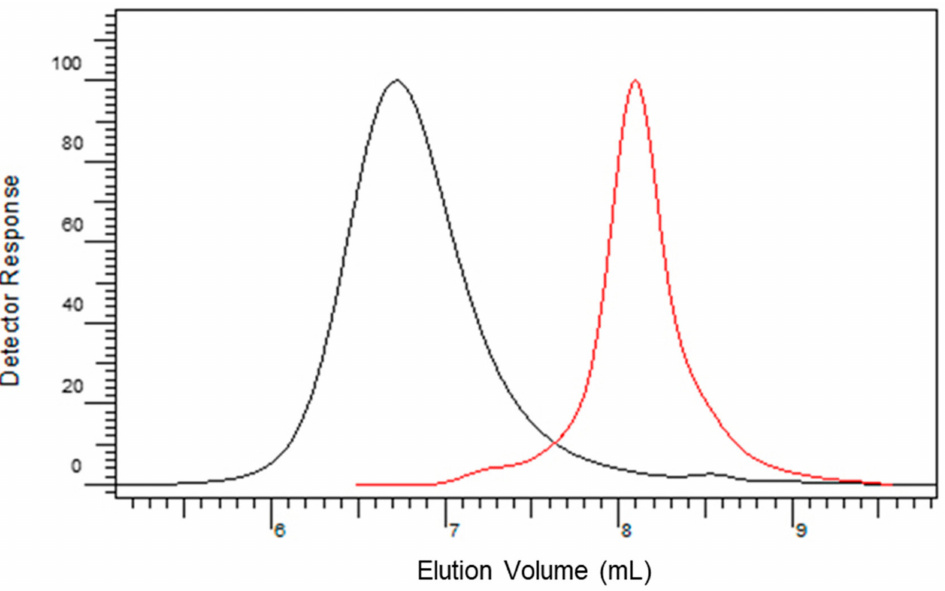
Figure 3. Size exclusion chromatogram of RU ( red curve, right ) and PR ( black curve, left